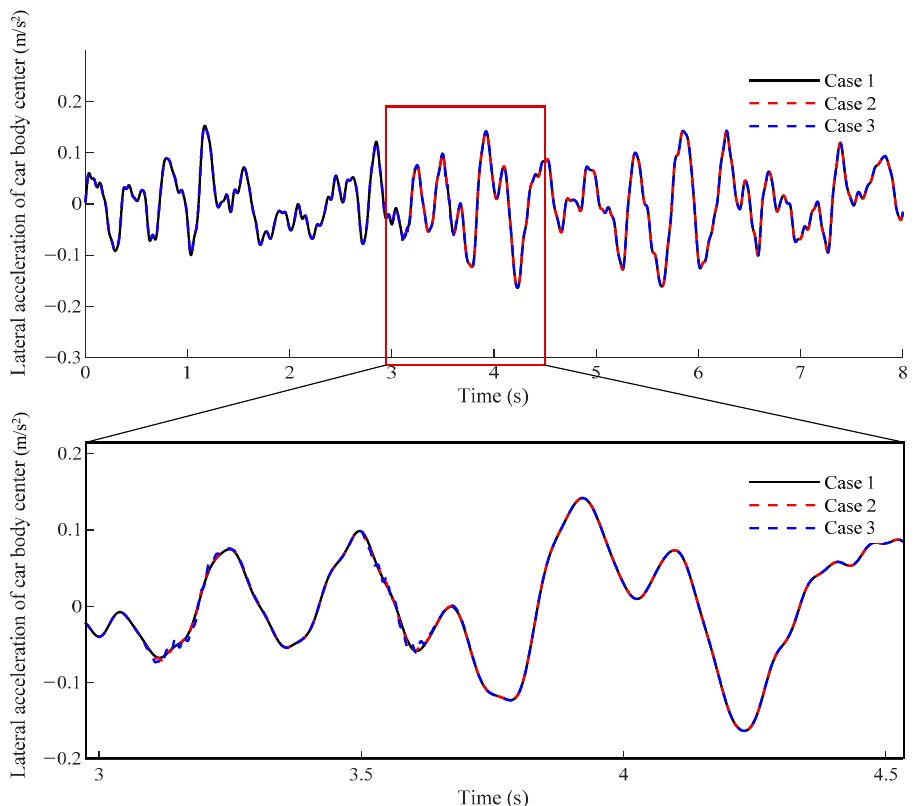
Figure 6. Time–history curve of car body lateral